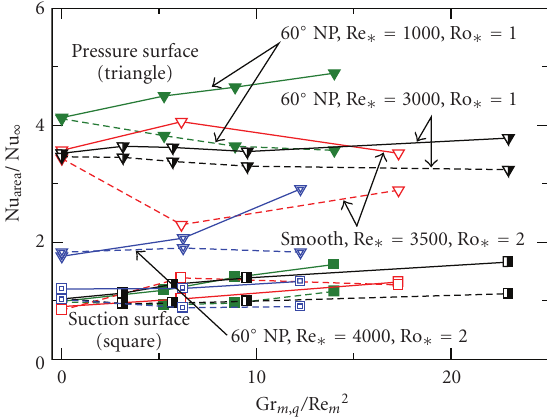
Figure 9: Buoyancy e ff ect on area-averaged Nusselt number at developed region in straight passes (Averaging area was between 5th and 6th ribs from straight pass entrance. Open, filled, half-filled, and concentric symbols are for (Re ∗ , Ro ∗ , smooth/rib) = (3500, 2, smooth), (1000, 1, rib), (3000, 1, rib), and (4000, 2, rib), resp. Symbols with solid and broken lines are for aiding and opposing buoyancy contributions,